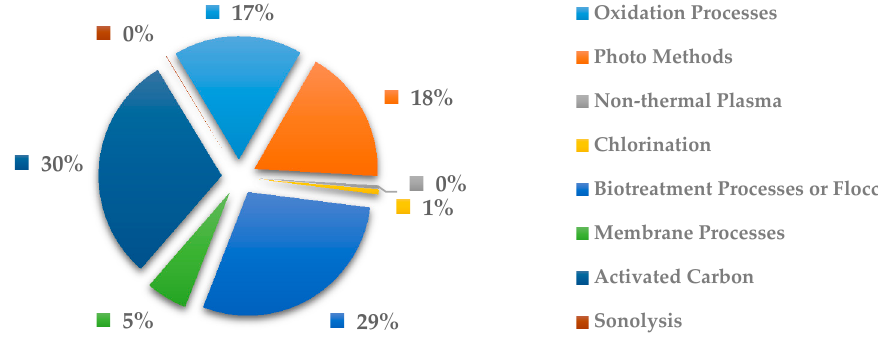
Figure 24. Percentage of scientific articles worldwide regarding wastewater treatments of anti-infective drugs between 1998 and 2020. Data collected in Scopus database by using wastewater or water as keywords and English as a language limitation.